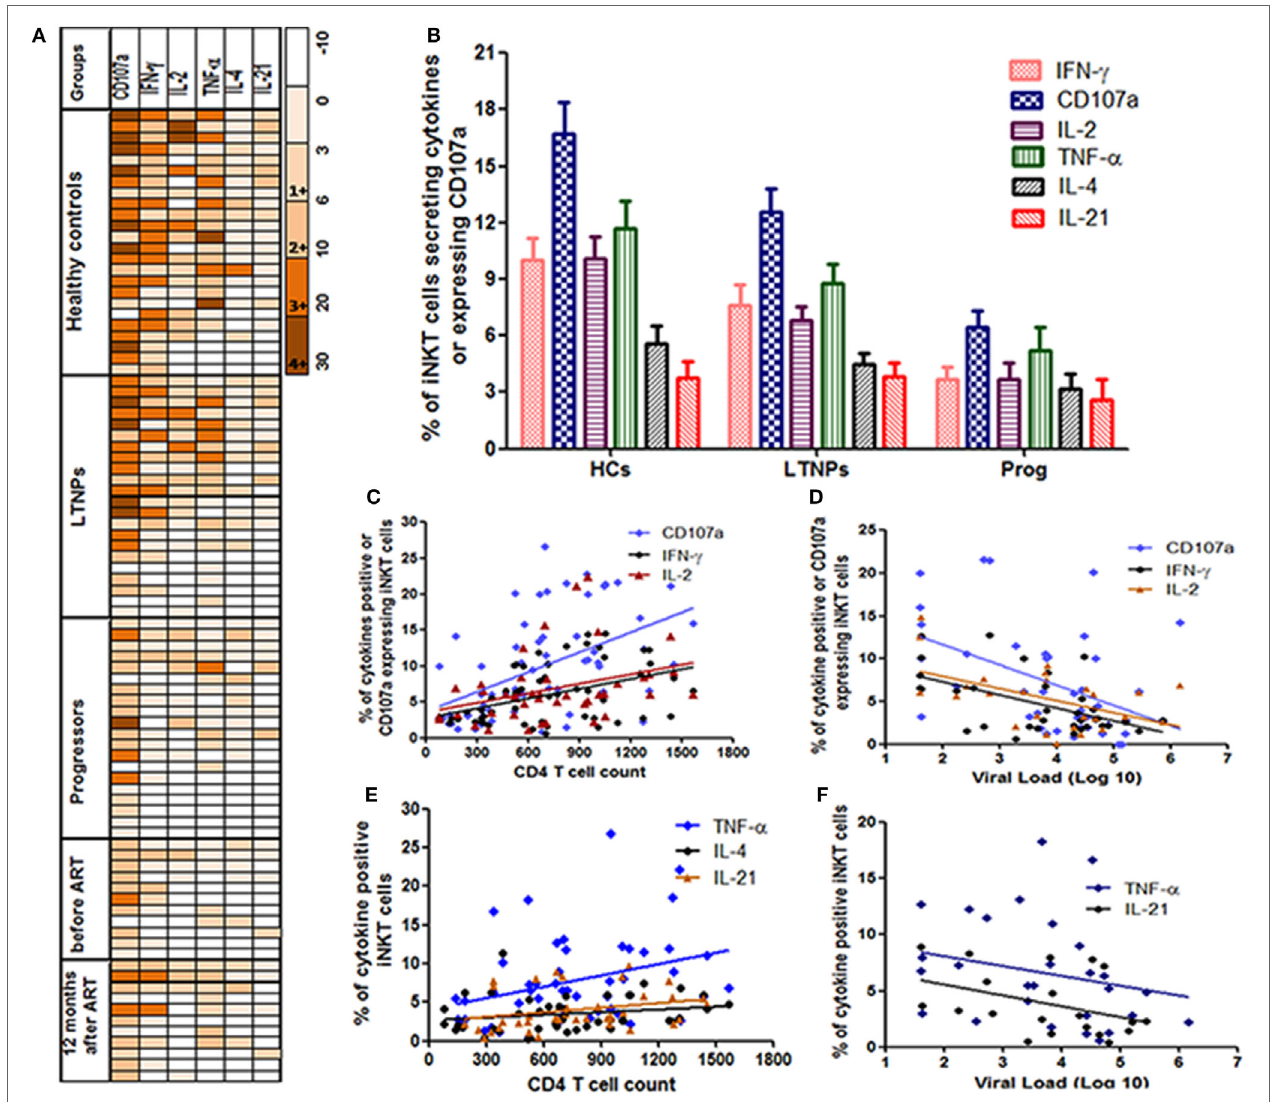
FigUre 2 | Assessment of the cytokines secretion profile of invariant natural killer T (iNKT) cells. (a) Heatmaps of iNKT cells secreting cytokines (IFN- γ , IL-2, TNF- α , IL-4, or IL-21) or expressing CD107a from all study groups [HCs, long-term non progressors (LTNPs), progressors, before, and post anti-retroviral treatment at 12 months]. Only responders are represented in the heatmaps (each row is single participants). For each particular cytokine, the functional response has been graded from 1 + to 4 + according to the magnitude (% of iNKT cells secreting cytokines or expressing CD107a). (B) The bar diagram shows the response (% of iNKT cells showing intracellular cytokine secretion/CD107a expression after stimulation with α -GalCer) on the Y -axis in different groups of study participants (HCs, LTNPs, and progressors). (c) The scatter plot shows the correlation analysis for percent of IFN- γ+ , IL-2 + , and CD107a + iNKT cells ( Y -axis) with corresponding CD4 T cell counts on the X -axis and (D) plasma viral load (pVL) (RNA copies/ml) on the X -axis. (e) The scatter plot shows the correlation analysis for percent of TNF- α+ , IL-4 + , and IL-21 + iNKT cells ( Y -axis) with corresponding CD4 T cell counts on the X -axis and (F) pVL (RNA copies/ ml) on the X